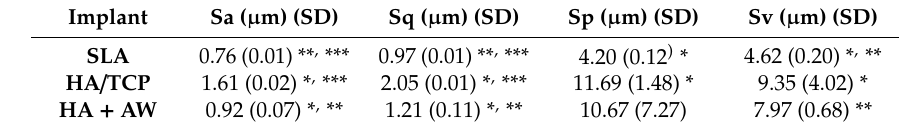
Table 4. Three-dimensional surface roughness parameters.